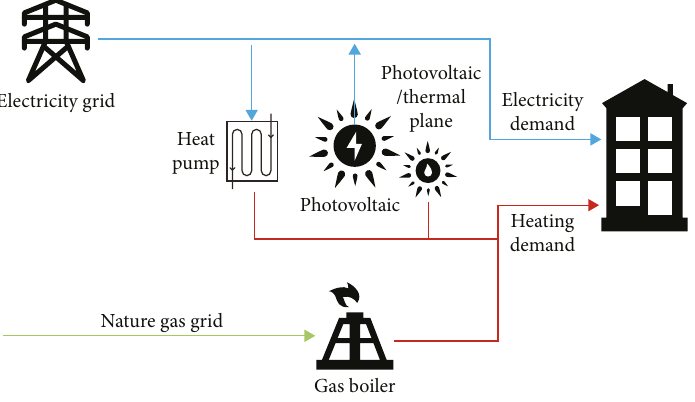
Figure 6: EH system structure for the